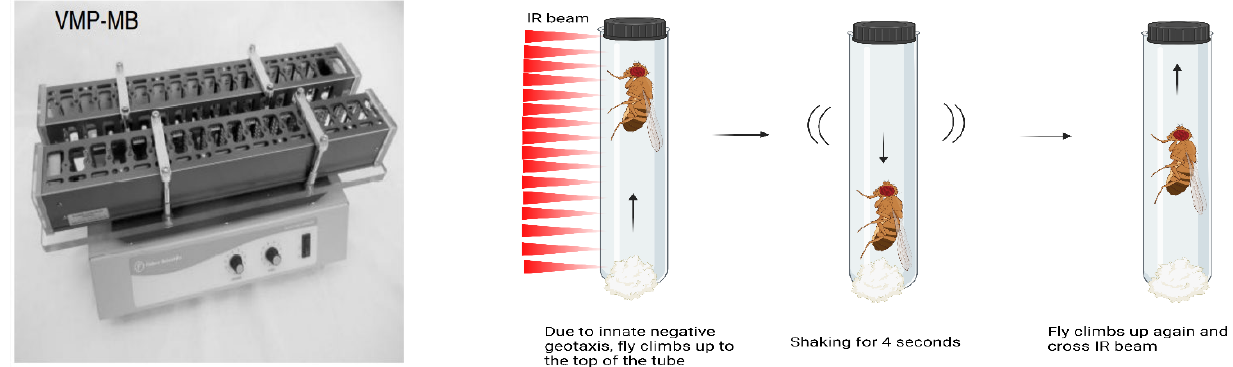
Figure 1. Schematic representation for the Forced-Climbing System. The left image is VMP-MB where the upper portion is two slots of MultiBeam Activity Monitor (MB), each has 16 slots for tubes and each slot is equipped with 17 IR beams and the lower portion is Vortexer Mounting Plate, (VMP) which is used as a shaker. The right picture shows how the Forced-Climbing System works. Simply, an anaesthetized fly was placed inside the tube plugged with cotton from the bottom and with a black cap from the top. Then, the tube was placed inside MB. Each MB consists of 16 slots. The VMP agitates tubes inside MB for 4 s each minute. The fly tends to climb up against gravity due to innate negative geotaxis. Then, after a four-second shaking period, the fly falls to the bottom and climbs up again to the top of the tube and crosses the 17 IR beam. The left image was taken from TriKinetics.com, accessed on 1 August 2022 (with permission) while the right was created with